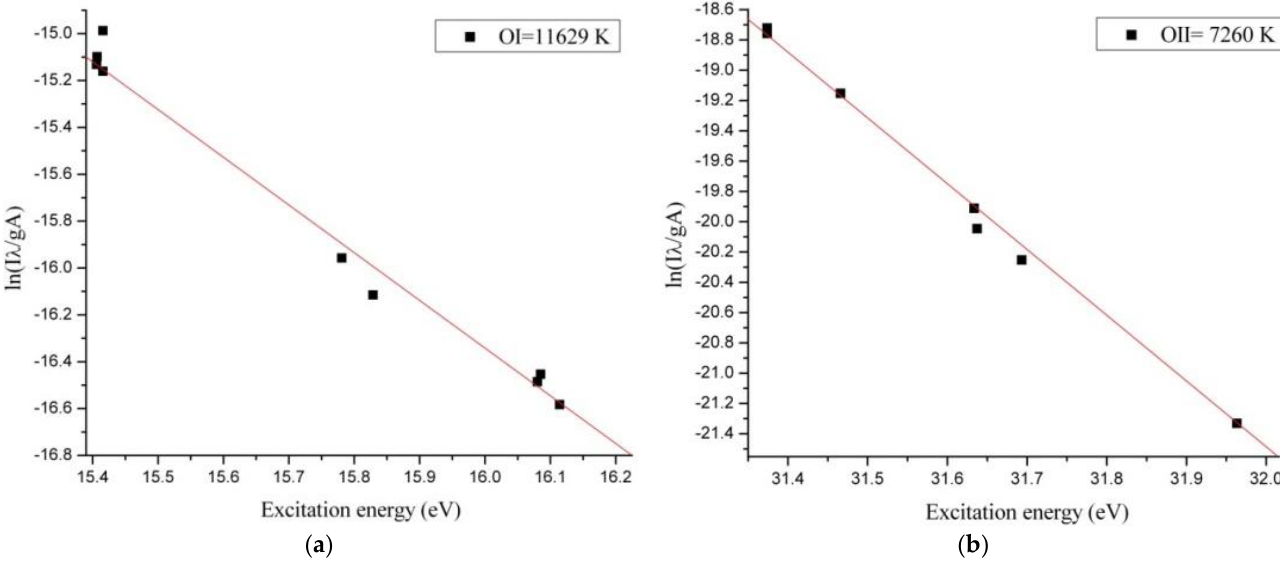
Figure 7. The Boltzmann Plot for ( a ) OI in the air at normal pressure and ( b ) for OII in air at normal pressure. I: intensity of spectral lines, λ: wavelength of spectral lines, A: transition probability, g: the statistical weight of upper energy level, Excitation energy (eV): energy level of the upper state.